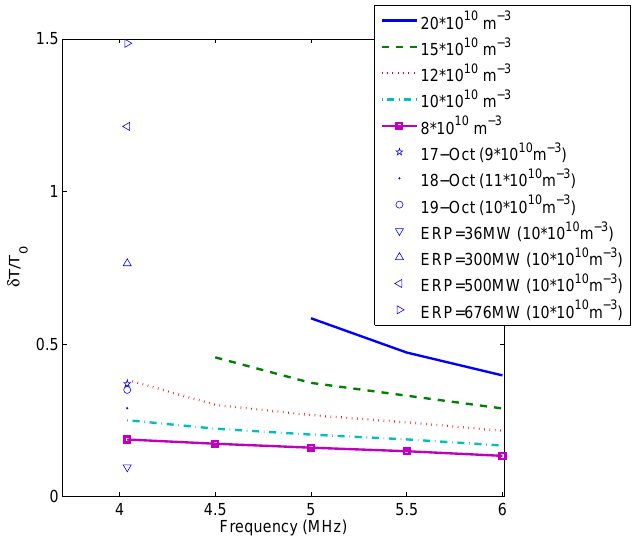
Fig. 6. Temperature increase as a function of heater frequency, ob- served values plotted as comparsion.